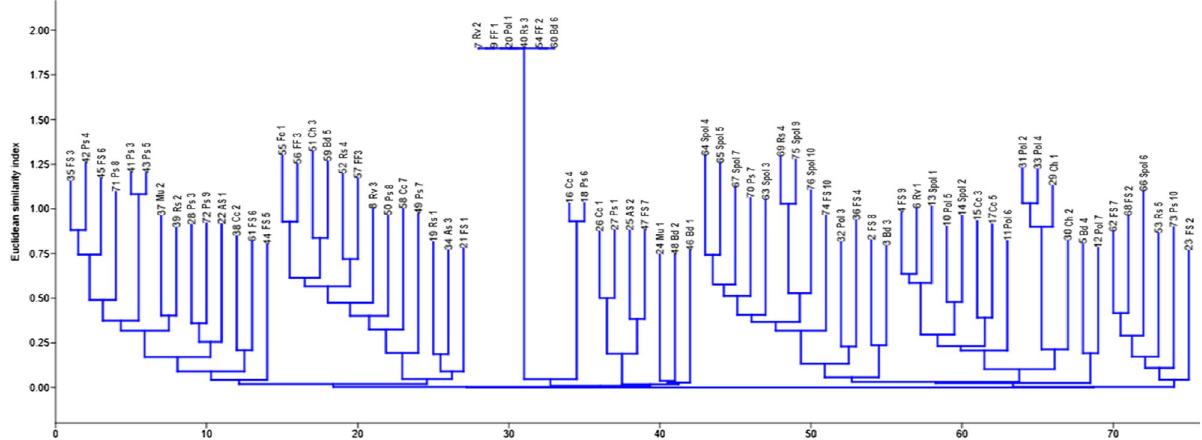
Figure 1. A neighbour-joining dendrogram of ERIC-PCR fingerprints of L. monocytogenes strains indicates similarities between clustered isolates and their sources. Pol, polony; Spol, sliced polony; FS, fruit salad; Ch, chips; FF, fried fish; Rs, Russian sausage; Rv, red Vienna; Bd, bread; Fc, fried chicken; Vk, vetkoek; Mps, meat pie; Cc, cupcakes; Mu, muffins; As, assorted